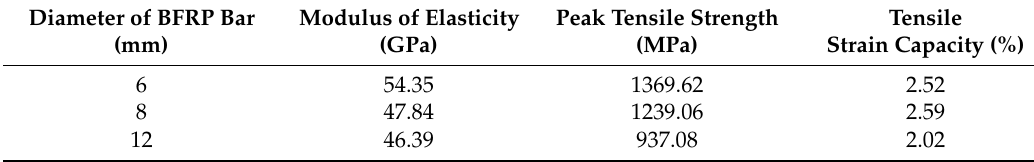
Table 4. Material properties of BFRP